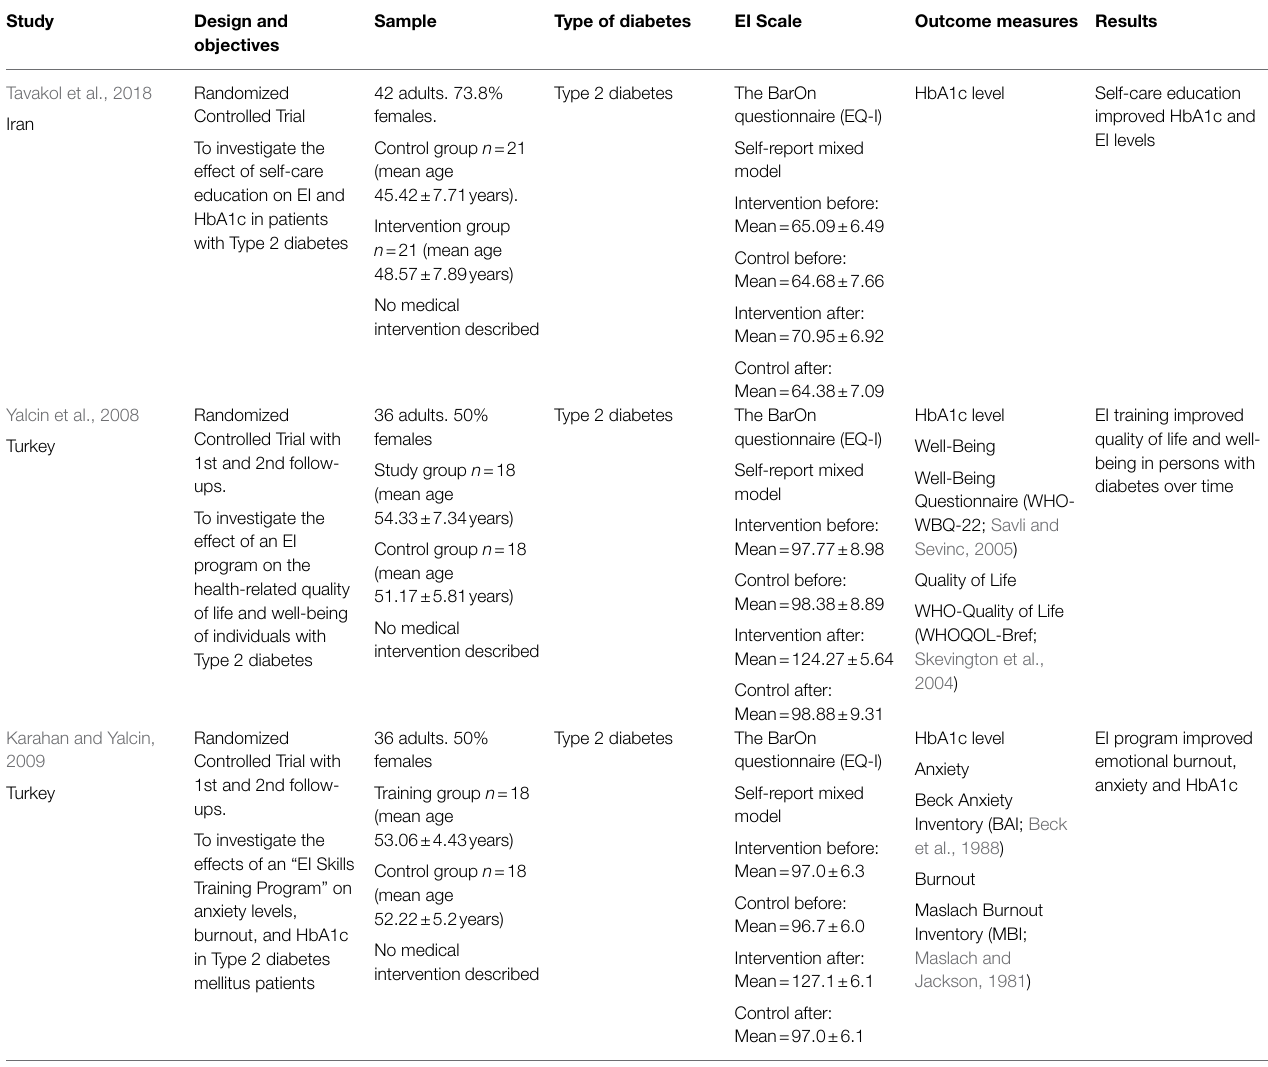
TABLE 3 | Studies analyzing EI training in people with diabetes.